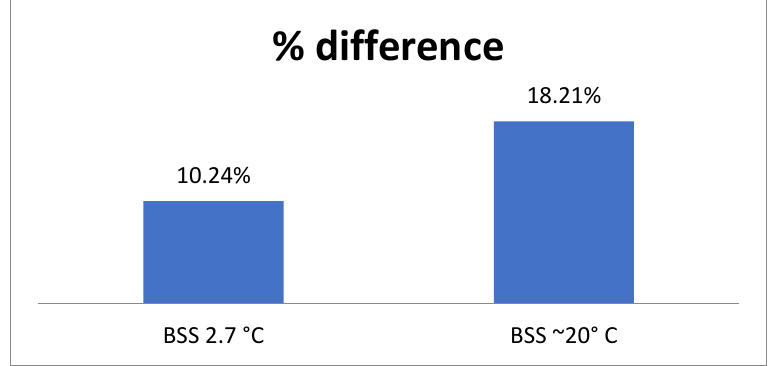
Figure 4. Percentage differences in loss endothelial cells using BSS at 2.7 °C (Group B) and at ~20 °C (Group A), pre- and post- treatment. Table 6. One-way ANOVA results.